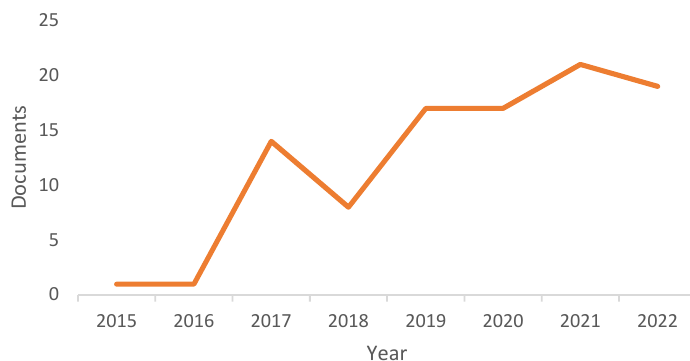
Figure 3. The annual publication of articles that have been reviewed.